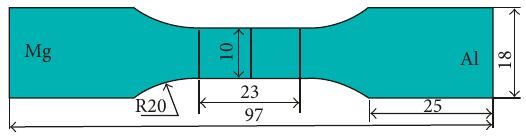
Figure 1: Analysis model.